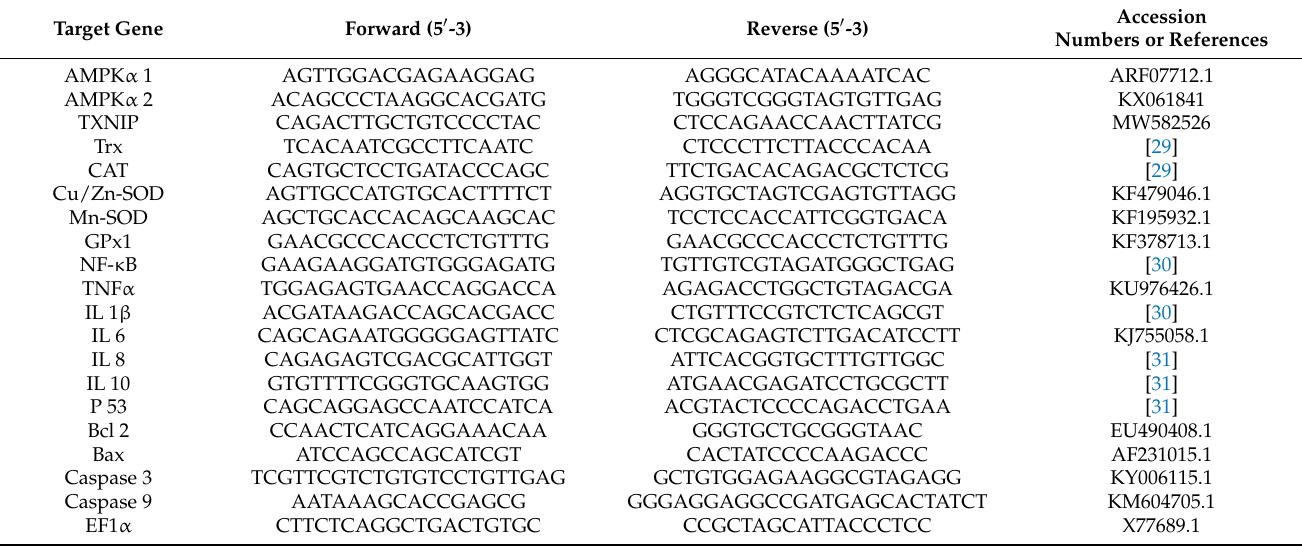
Table 2. Nucleotide sequences of the primers used to assay gene expressions by real-time PCR. Target Gene